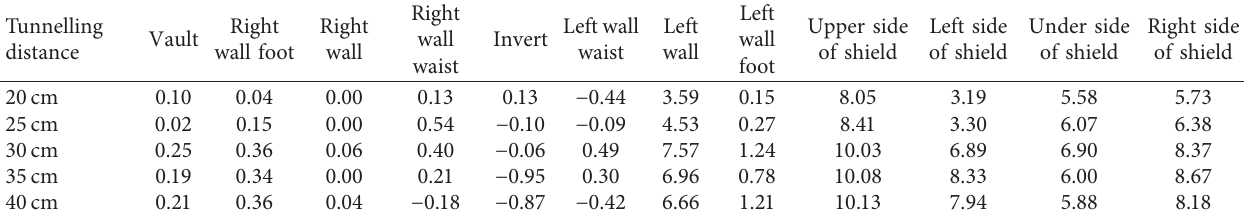
Table 6: Variation of earth pressure at different measuring points (unit: